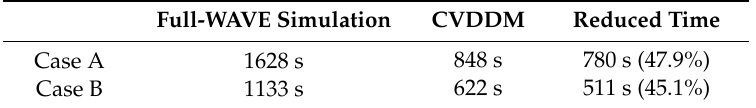
Table 4. Example of simulation time